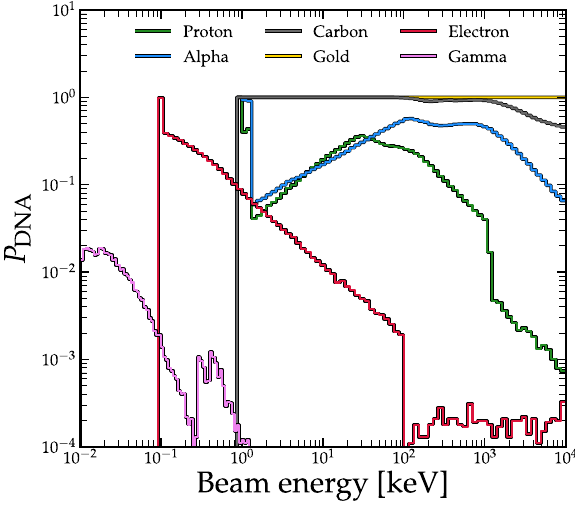
Fig. 3 Probability of particle-DNA interaction depositing an energy larger than 10 eV in a single component volume of the DNA, when the beam was fired directly at a strand. This is a proxy for the particle- DNA cross-section for severing a strand. The spurious threshold effects around 0.1 keV and 100 keV for electrons and 1 keV for ions are due to limitations of the available electromagnetic physics models. Hence we will generate or study incident particle energies outside of these ranges where we are not able to simulate the complete